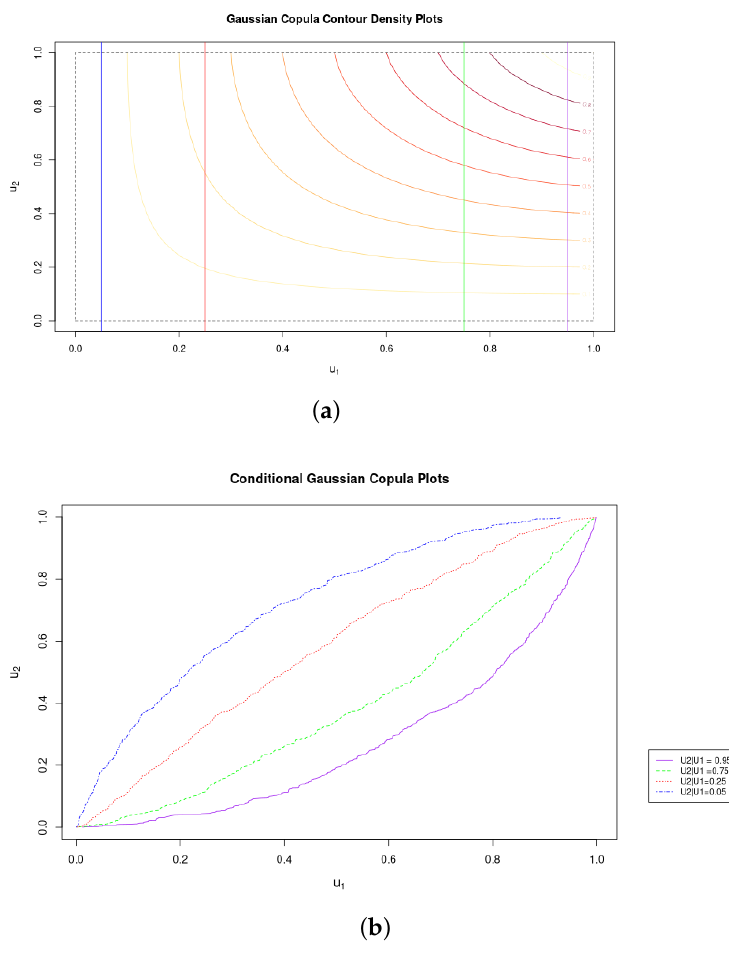
Figure 2. Conditonal Copula CDFs. ( a ) Contours of Gaussian Coupla with Marginal Distributions (See legend in ( b ). ( b ) Marginal Conditional Distributions of the Gaussian